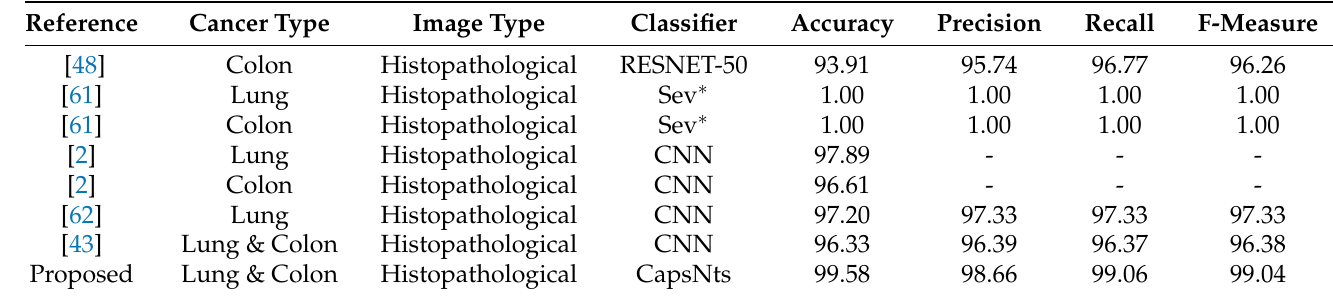
Table 4. Comparison of the results produced by the proposed model with the state-of-the-art techniques. CNN: Convolu- tional Neural Networks, CapsNts: Capsule Networks, Note: Results are given in percentage. Sev ∗ : Several pre-trained models were used including VGG16, ResNet50, InceptionV3 , InceptionResNetV2, MobileNet, Xception, NASNetMobile,